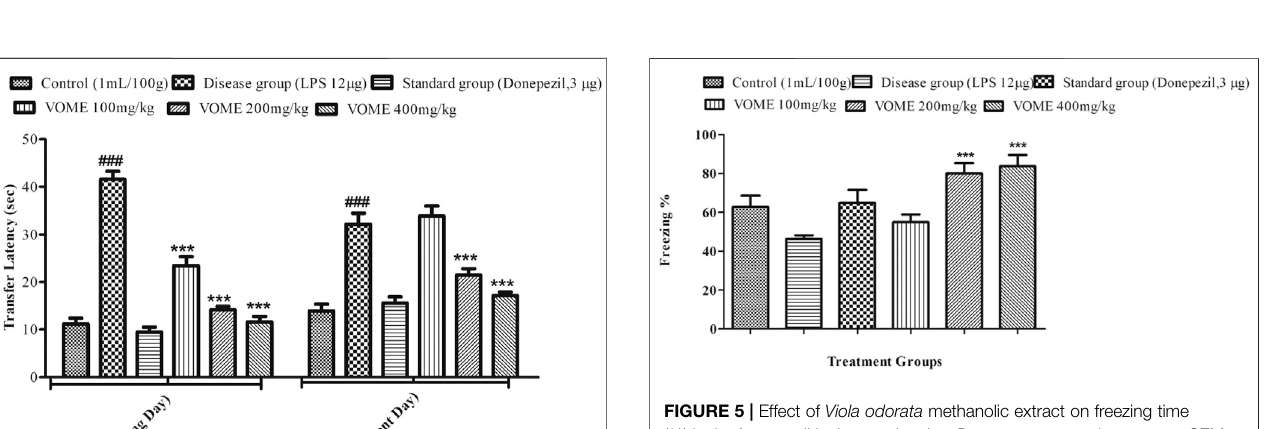
FIGURE3| Effectof V.odorata methanolicextractonbehavioralparametersoftheMorriswatermazetestinmice.Histogramsshowing (A) escapelatency, (B )No. ofcrossings,and (C) time spentinquadrant. Dataareexpressedasmean ± SEM( n (cid:1) 10).* p < 0.05,** p < 0.01and *** p < 0.001ascompared totheLPStreatedgroup. ### p < 0.001 as compared to the control group.